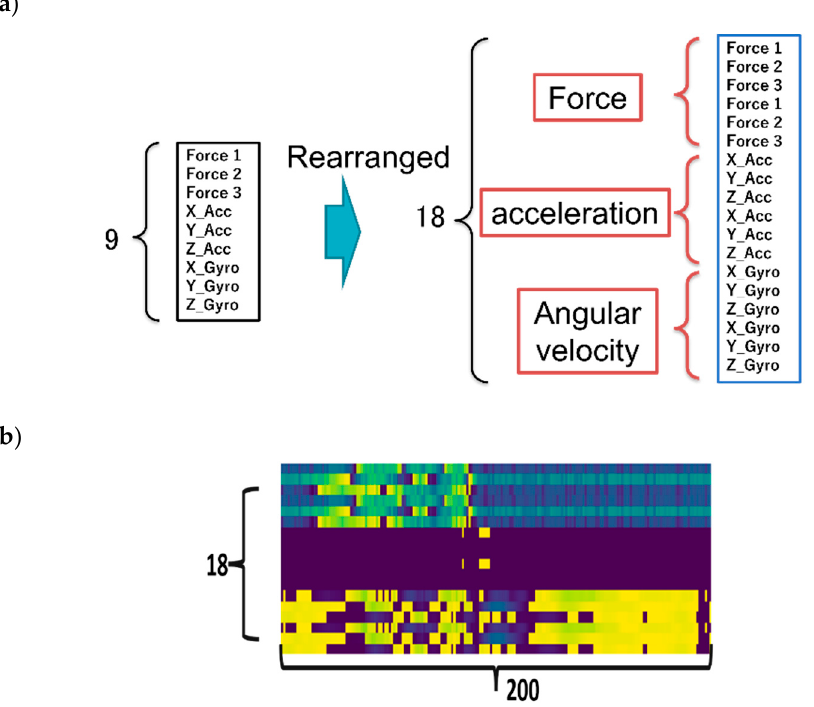
Figure 6. ( a ) The structure of a dataset. ( b ) the resultant dataset, virtual image.